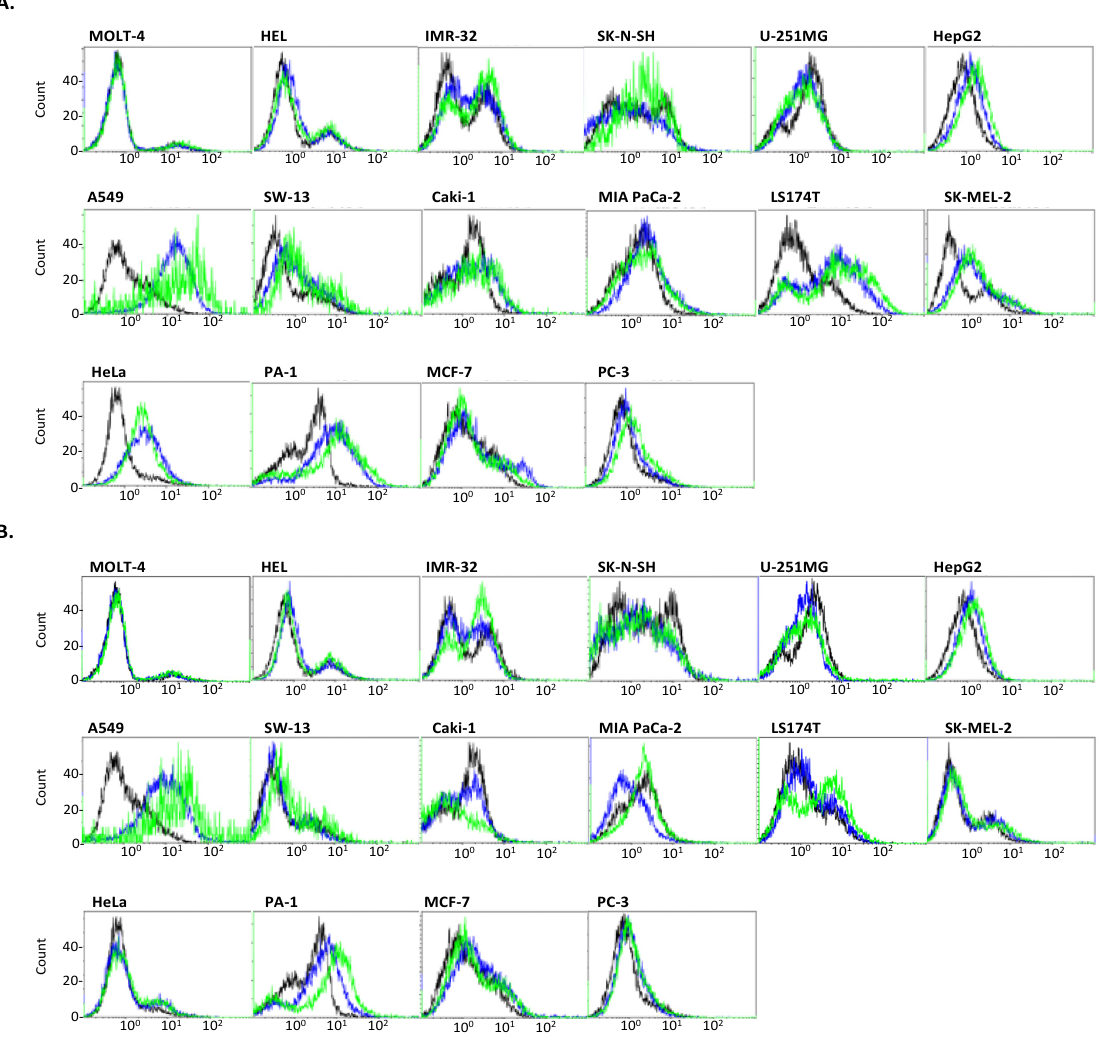
lines, anti-sialoglycoconjugate antibodies (mouse IgM); red lines, anti-sialoglycoconjugate antibod- ies (mouse IgG). ( Q ) Western blot analysis of the cancer cell lines by 12E3 antibody for polySia–